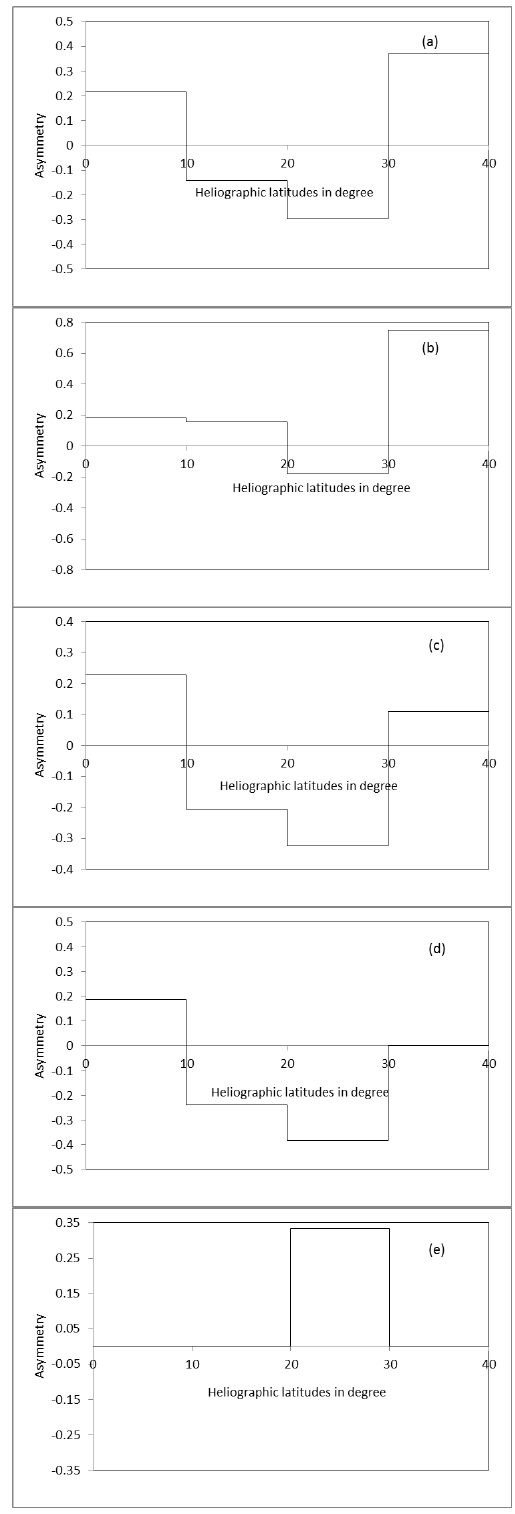
Figure 5. From top to bottom (a to e panels), plots of latitudinal asymmetry distribution for Total, B, C, M and X class SXR